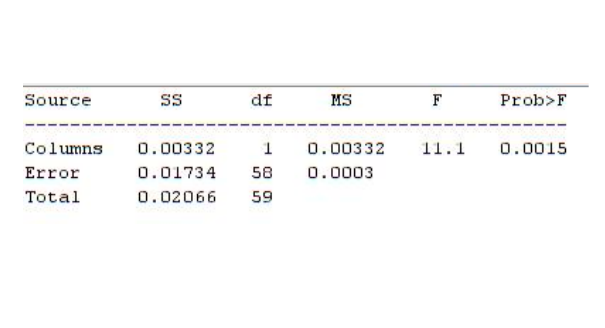
Figure 7. ANOVA test, F 1 indicator.